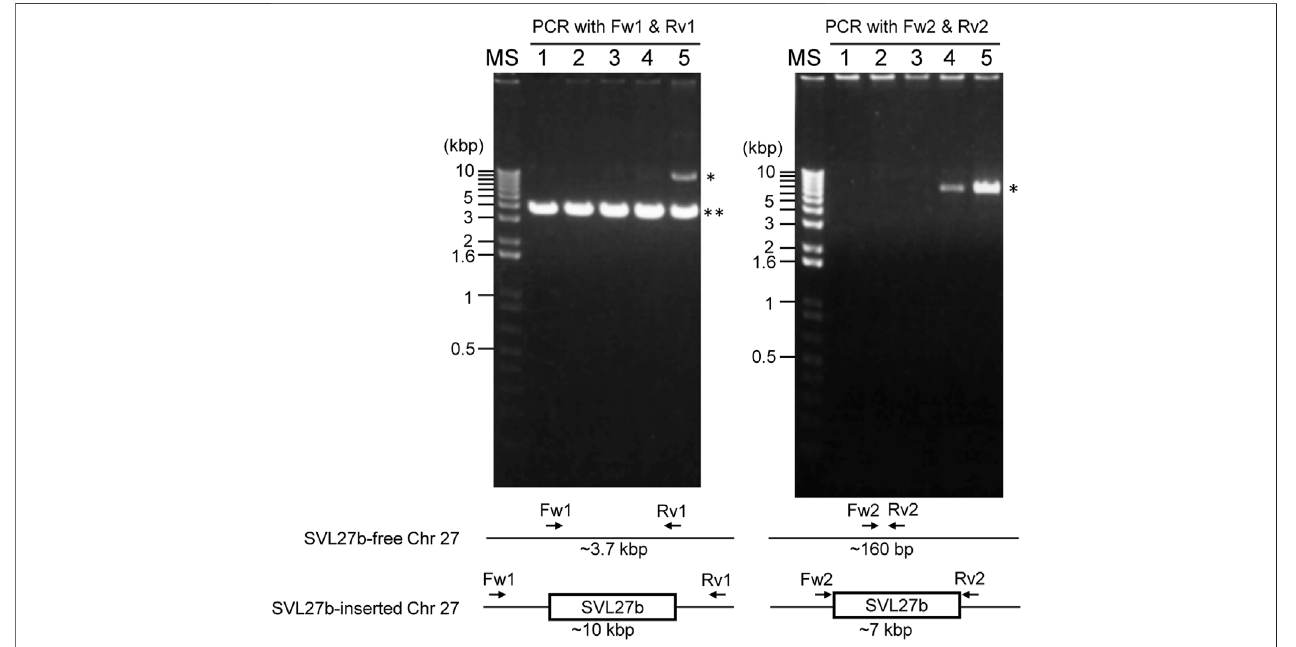
FIGURE 5 | Using genomic DNA prepared from various cells as a template, DNA fragments were ampli fi ed by PCR with two different combinations of primers. Sequences of the primers are speci fi ed in the Materials and Methods. 1) AGM lymphocytes; 2) Vero JCRB0111; 3) Vero CCL-81; 4) Vero 76; 5) Vero E6. *, fragment containing SERV; **, fragment not containing